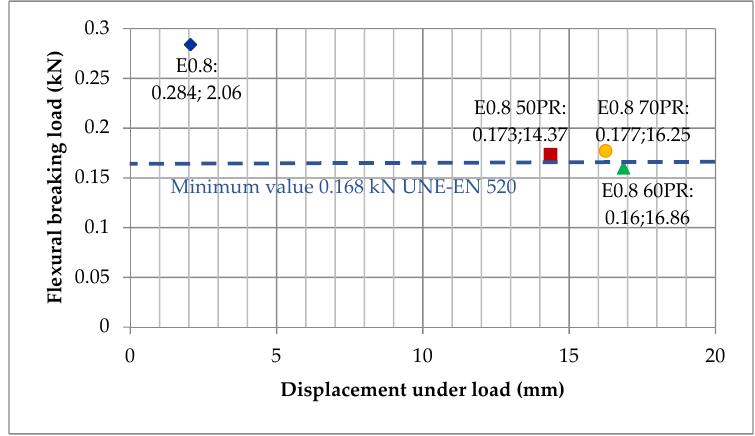
Figure 8. Average load-displacement values of the composites (UNE-EN 520).